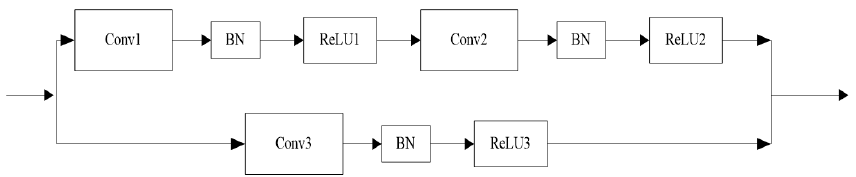
Fig. 4 Residual block structure B.